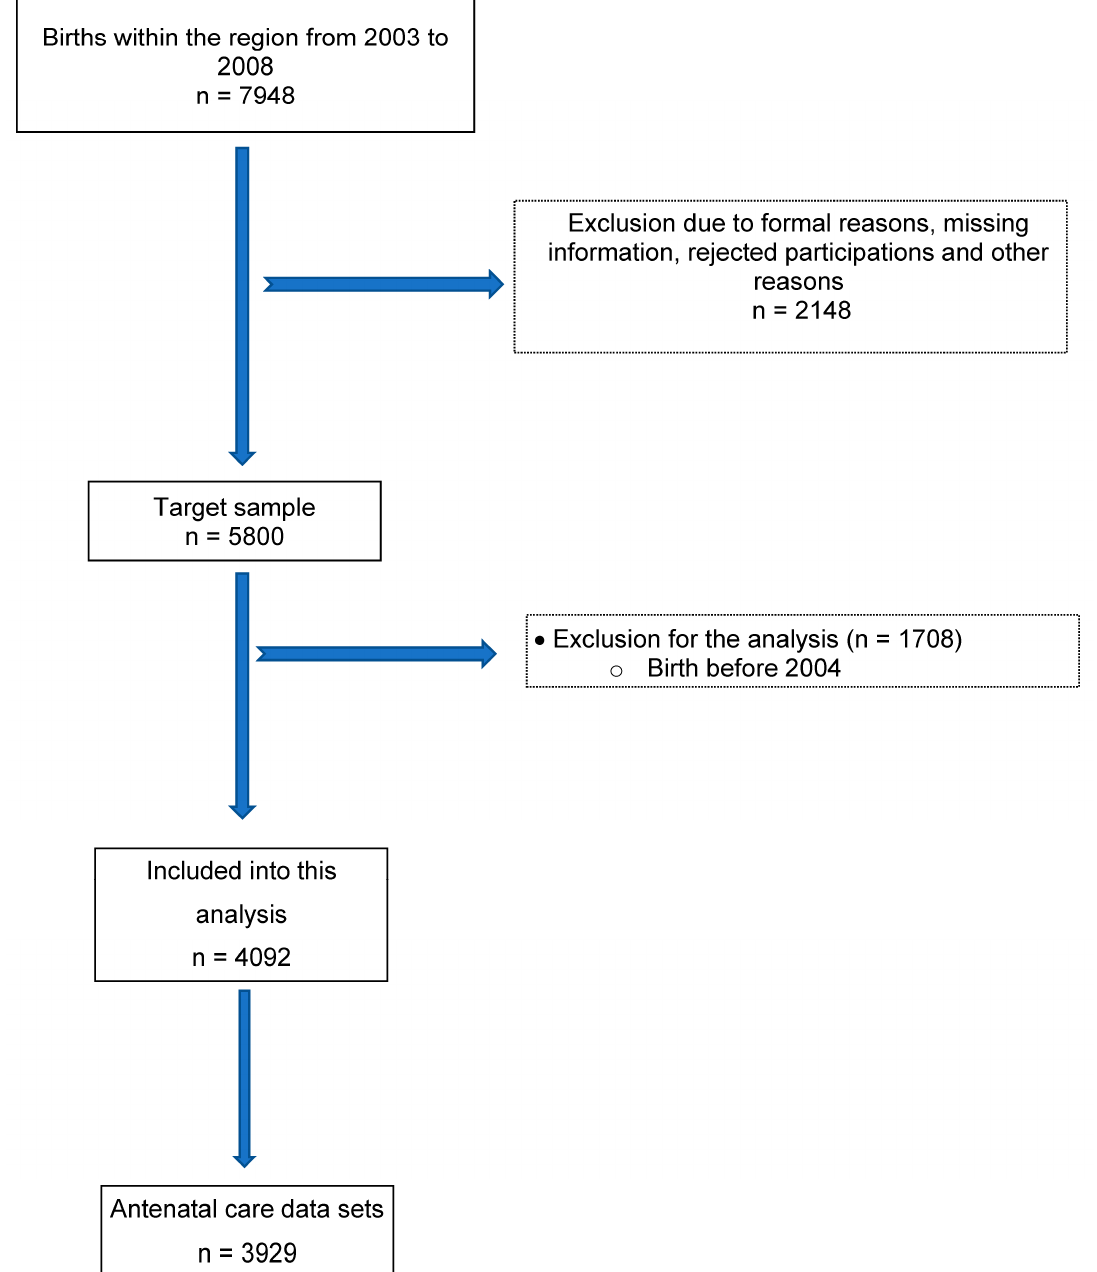
Figure 1. Flow diagram showing selection procedure apply to data from SNiP-I Study (Survey of Neonates in